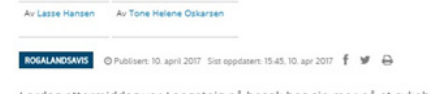
Figure 1. Social issues: nursing home food. Consumer